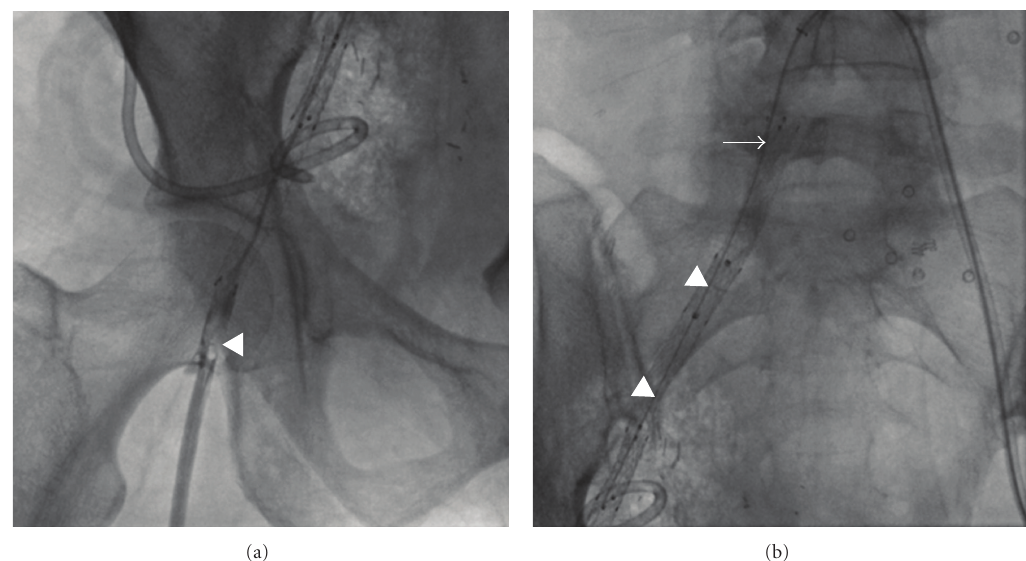
Figure 5: Right common femoral arteriogram (a) reveals acute thrombosis (arrow) of distal segment of stented artery. Of note, unsaved manual injections of contrast better documented thrombus burden throughout entire course of stented iliac artery segment. Fluoroscopic spot image (b) shows 5 French catheter (arrow) and infusion wire (arrowheads) system used for catheter-directed thrombolysis.